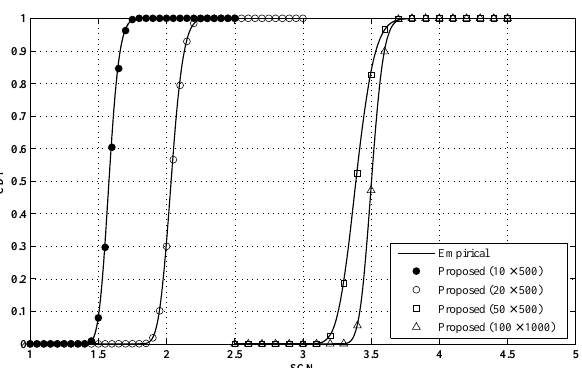
Figure 1. Empirical CDF of the SCN and its corresponding proposed GEV approximation for different values of K and N under H 0